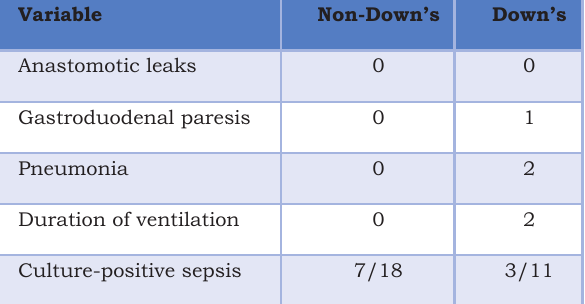
Table 4: Post‑operative